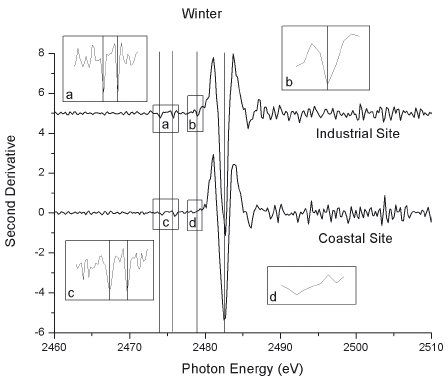
Figure 4. Second derivative of the sulphur K-edge XANES spectra for the PM10 samples in the two sites of the two sites collected during the winter season (zoomed areas a and c: detail between 2470 and 2478 eV; zoomed areas b and d: detail between 2478 and 2480 eV).